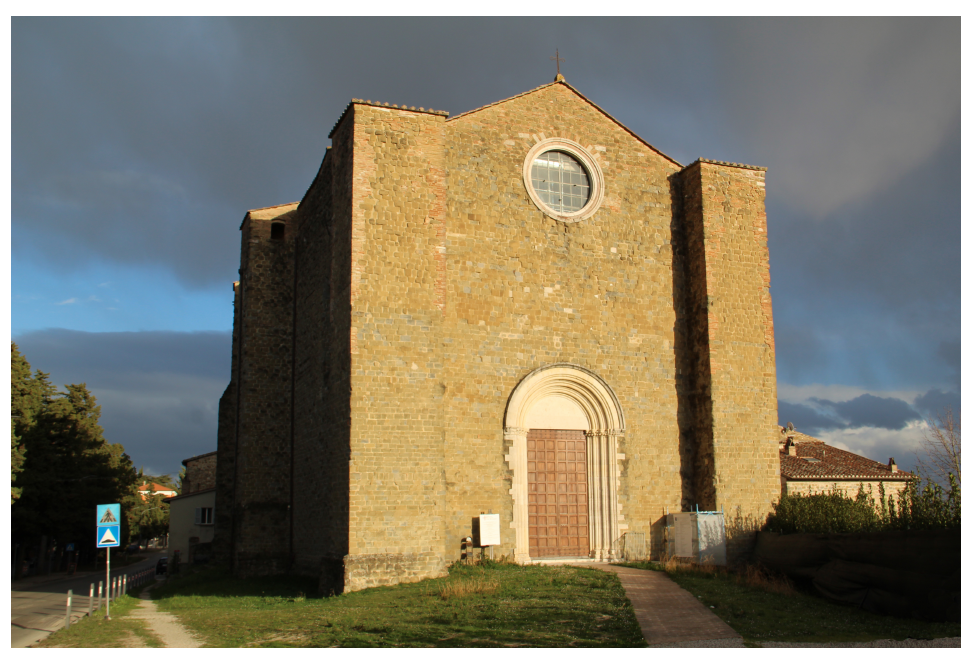
Figure 1. View from outside of the church of San